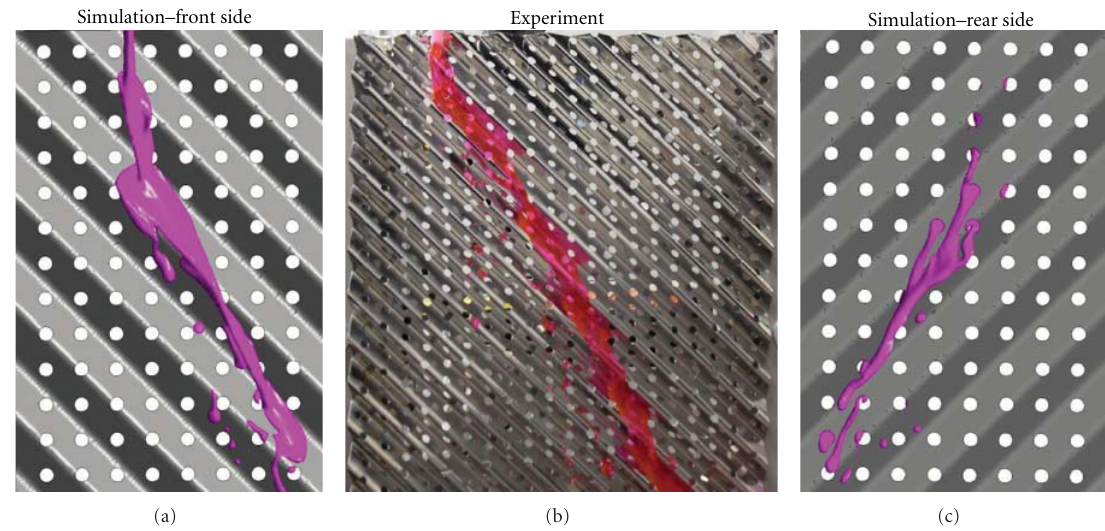
Figure 14: Comparison between simulation and experiment for flow of water-glycerol on corrugated sheet of packing with perforations. Flow rate: 590